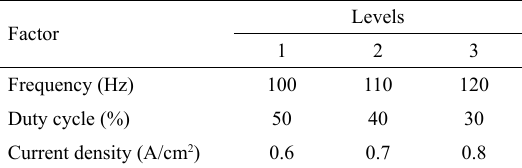
Table 3. Factors and